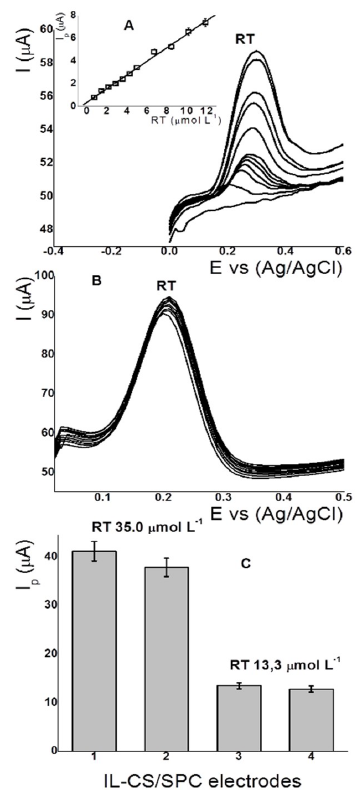
Figure 6. ( A ) Adsorptive voltammograms and calibration curve (insert) of RT between 0.75 − 12.5 µ mol L − 1 ; ( B ) adsorptive voltammograms (n = 10) for RT 35.0 µ mol L − 1 ; ( C ) and anodic peak current for RT 35.0 and 13.3 µ mol L − 1 using four different CS/SPC electrodes. Conditions: pH 2.5; E ADS 0.1 V; t ADS 60